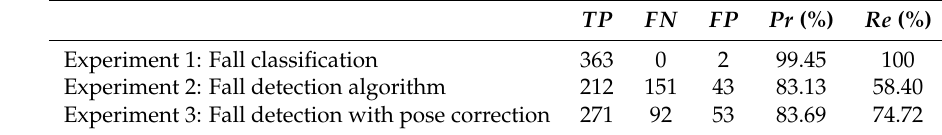
Table 5. Performance over the Intelligent Autonomous Systems Laboratory Fallen Person Dataset